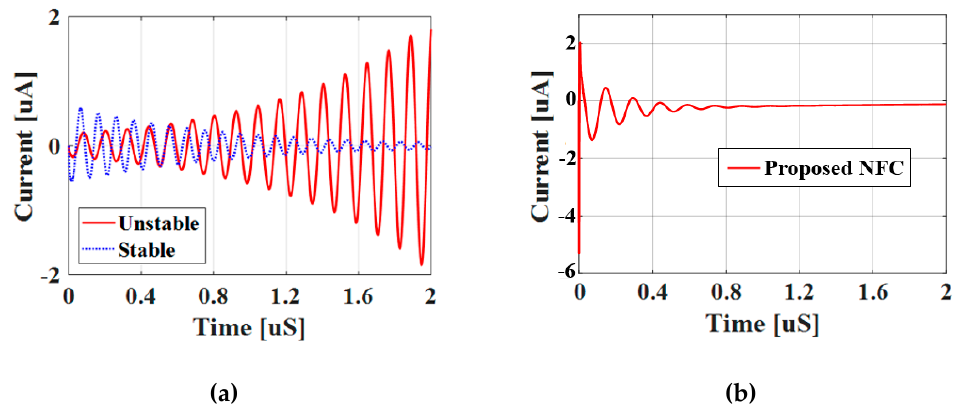
Figure 6. The transient responses of non-Foster circuits: ( a ) Examples of stable and unstable transient responses. ( b ) The transient response of the proposed non-Foster circuit.